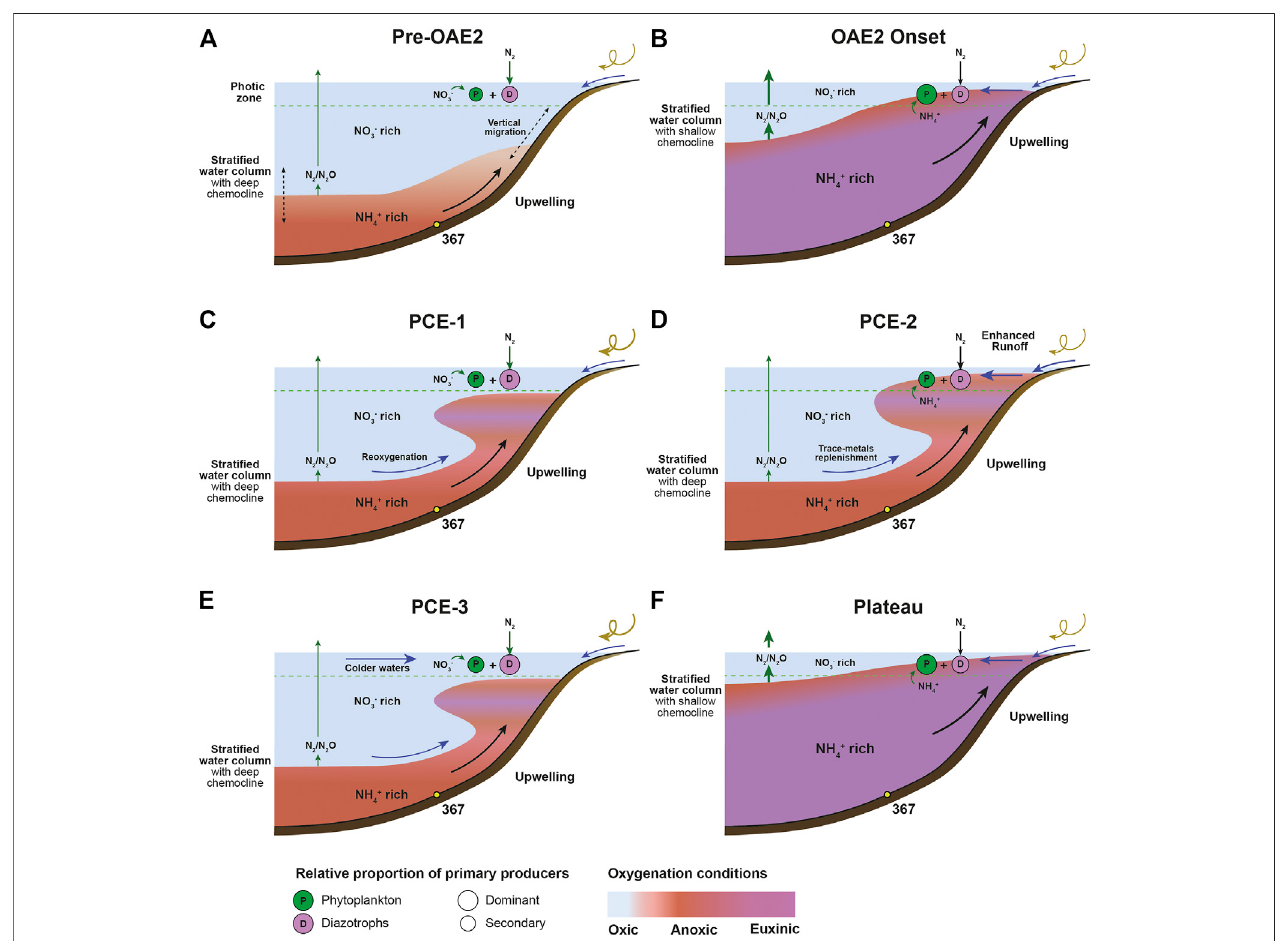
FIGURE11| Schematicrepresentationofthenitrogencycleandtheresultingnitrogenisotopicimprintofmarinesediments:BeforetheOAE-2 (A) ,duringtheOAE- 2 onset (B) , during the PCE-1 interval (C) , during the PCE-2 interval (D) , the PCE-3 interval (E) , during the plateau interval (F) . The red color indicates anoxic waters, the purple color euxinic waters and the blue color oxygenated waters (modi fi ed from Ader et al., 2014).